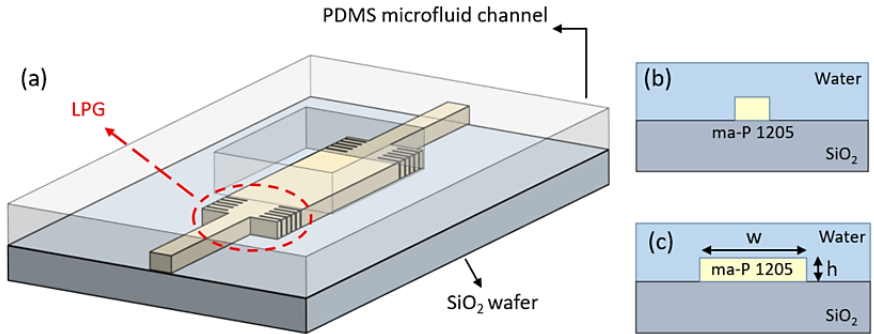
Figure 1. ( a ) Schematic of trimodal interferometer; ( b ) Input single waveguide cross-section; ( c ) Trimodal waveguide cross-section.